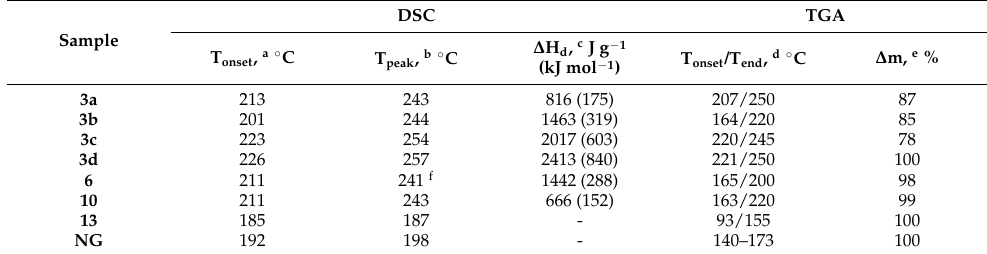
Table 4. Decomposition results (DSC-TGA